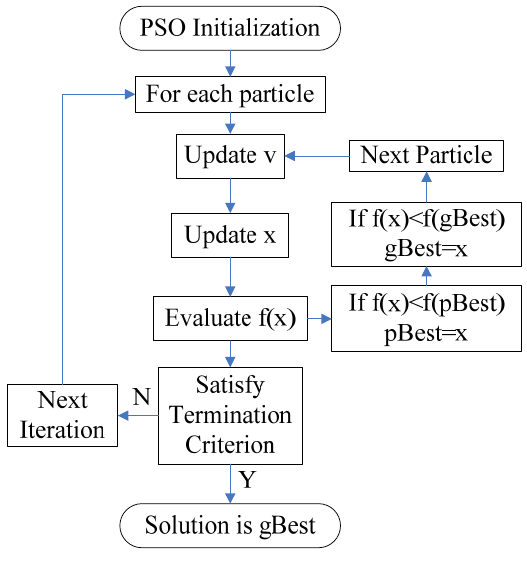
Figure 3. Flow chart of the PSO